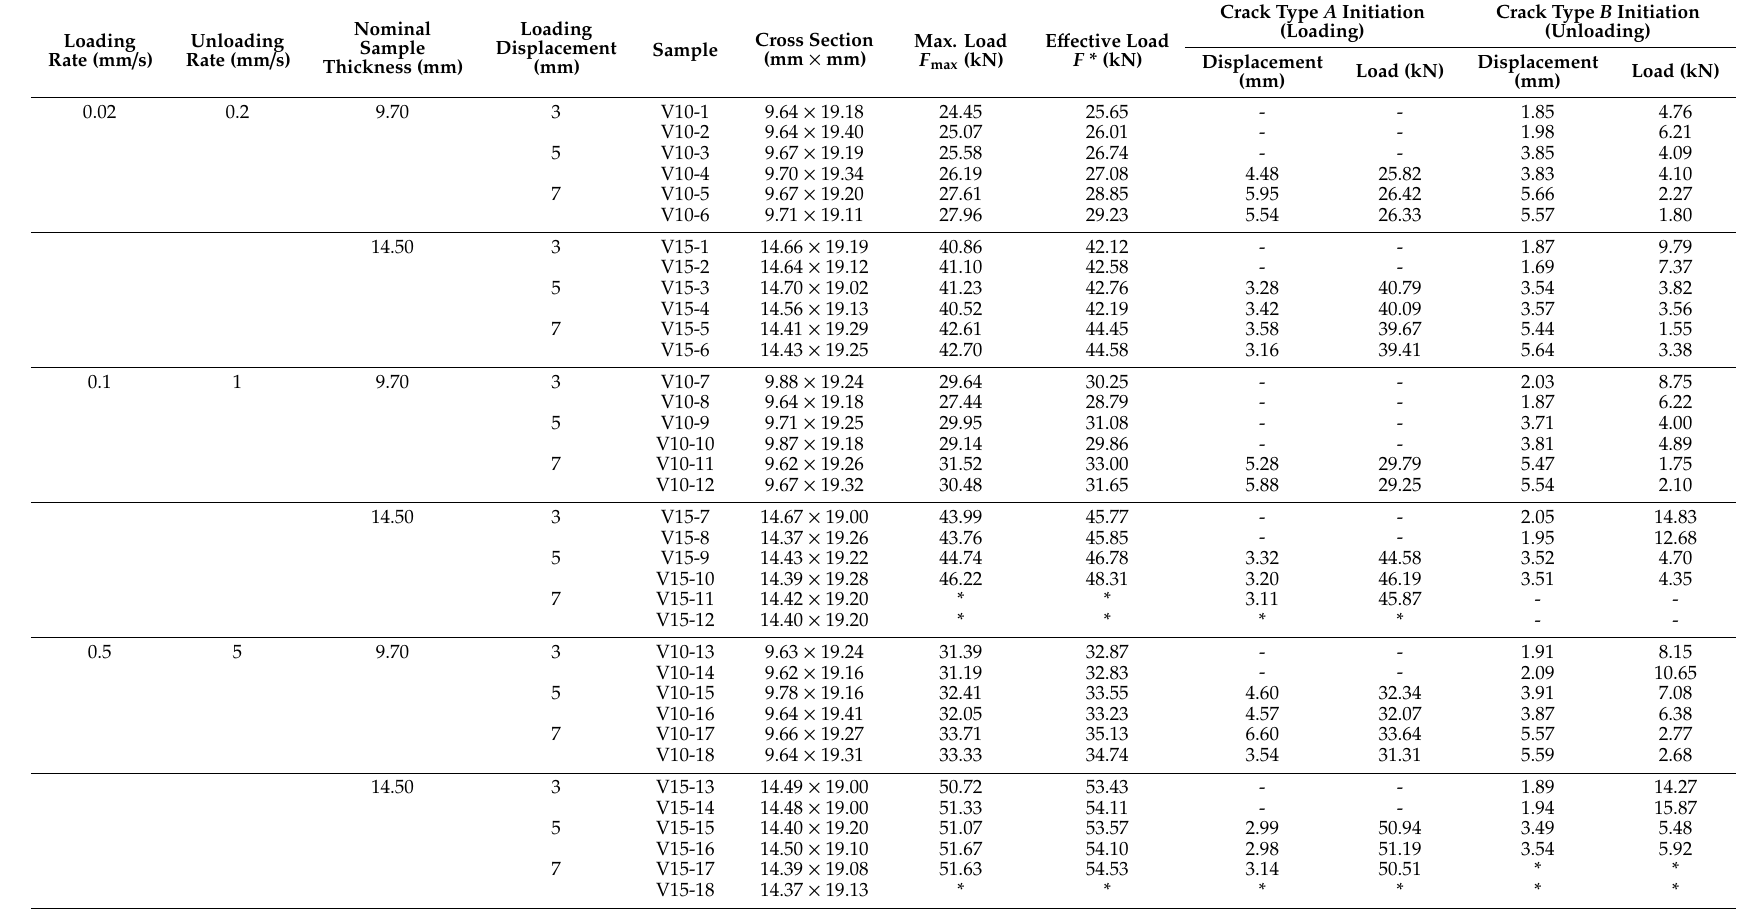
Table A2. Fracture load and displacement for the samples with sharp